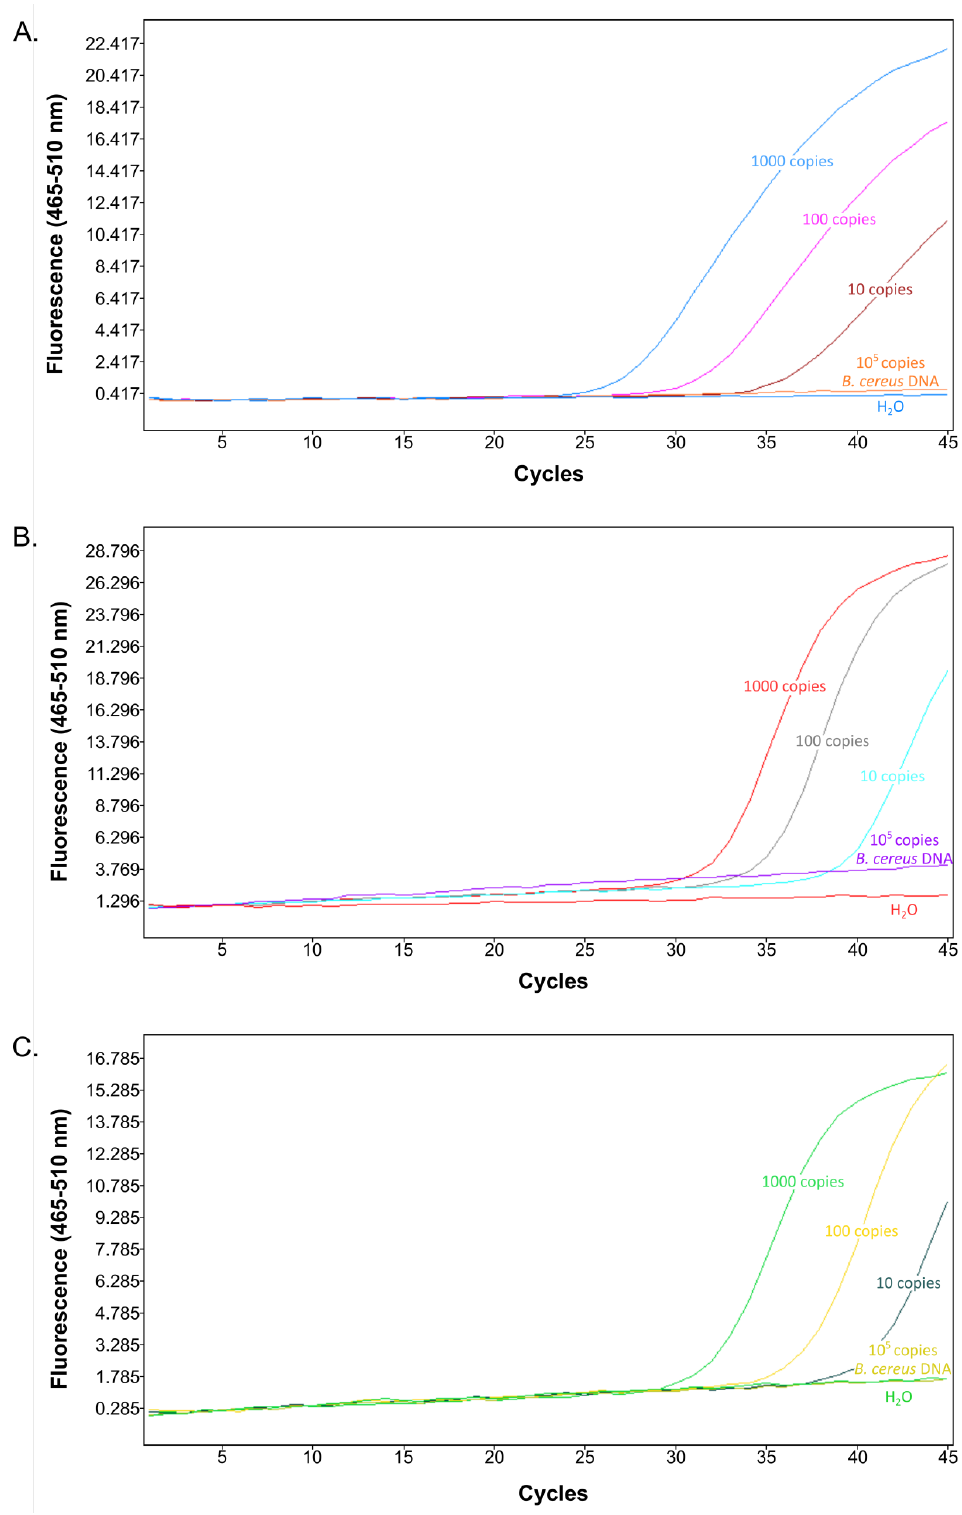
2 Figure 3. Comparison of the new 16S rRNA SNP-PCR assay with existing PCR assays. Different quantities of B. anthracis Ames template DNA (1000, 100, or 10 genome equivalents per reaction), non- target DNA (10 5 templates of B. cereus DNA), or water (negative) control were subjected to real-time PCR using the new 16S rRNA SNP assay ( A ), published dhp61 gene assay [9] ( B ) or published PL3 gene assay [6] ( C ). Representative amplification curves (from n = 3 with similar results) are